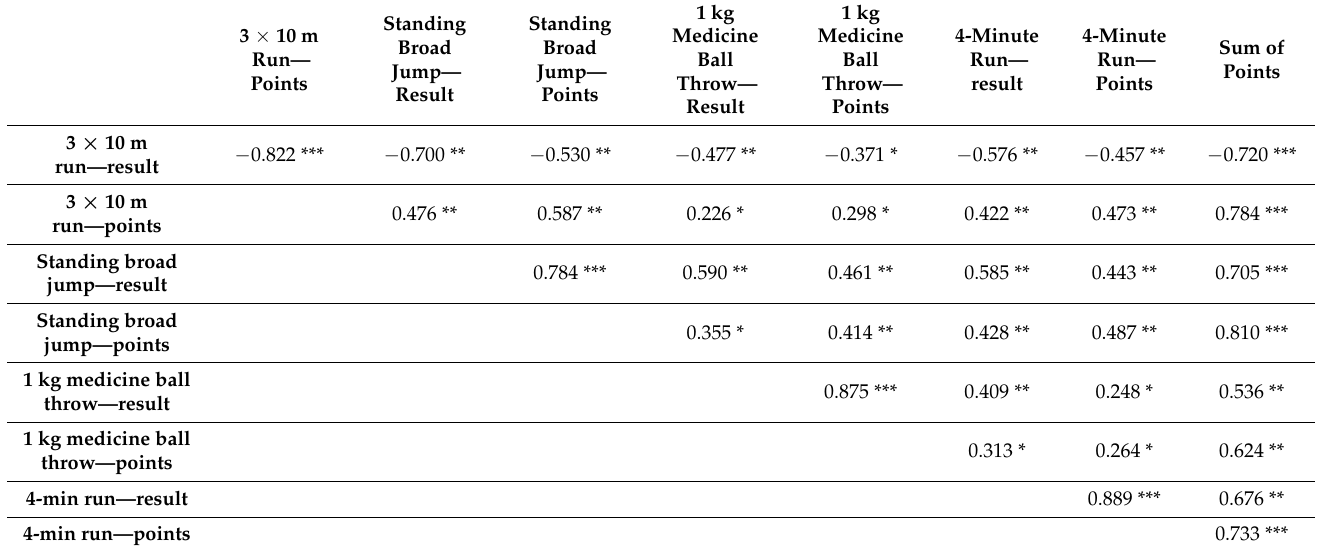
Table 12. OSF test results (raw scores and points)—Spearman’s correlation